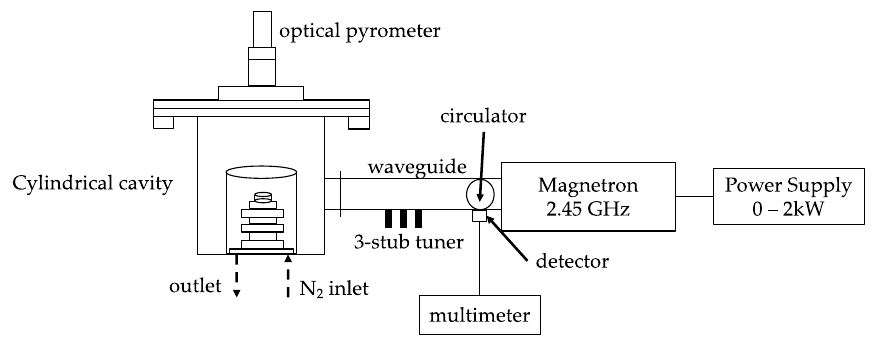
Figure 2. Schematic diagram of the microwave